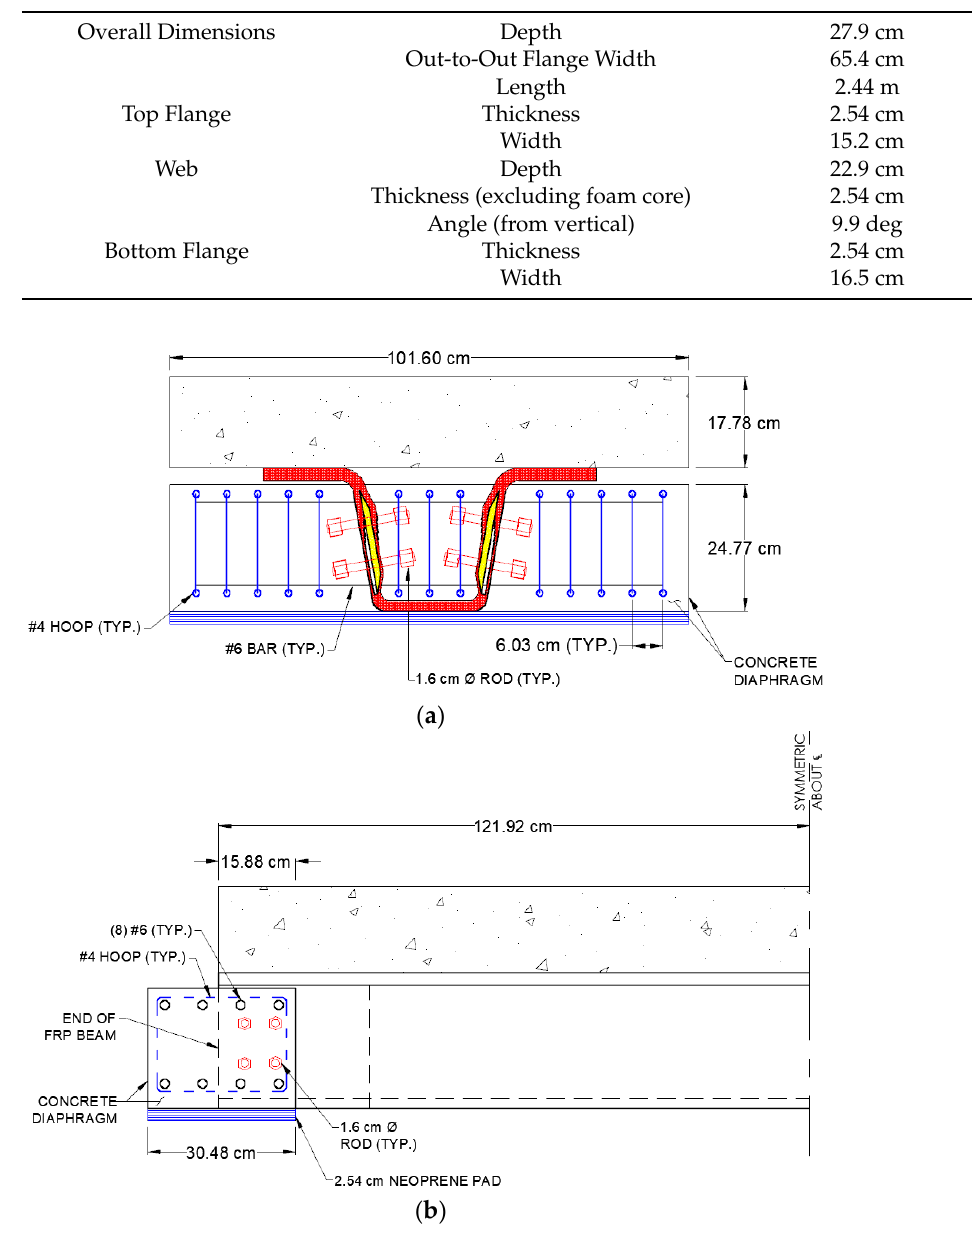
Figure 9. Details of Short Beam Specimens: ( a ) End Elevation; ( b ) Details of Short Beam Specimens.